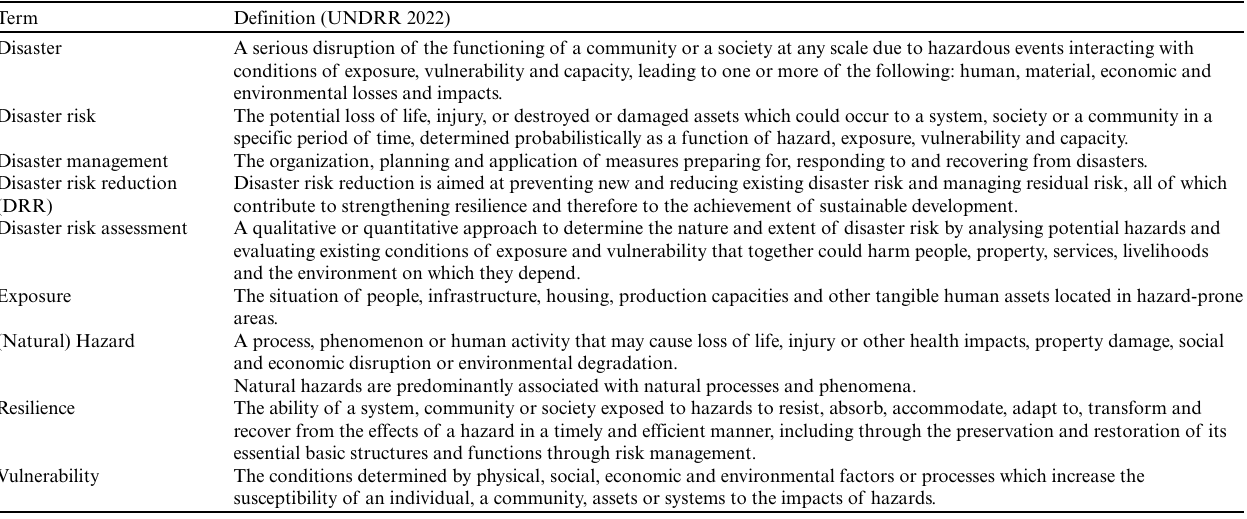
Table 1. United Nations Office for Disaster Risk Reduction terminology related to disaster risk reduction (UNDRR